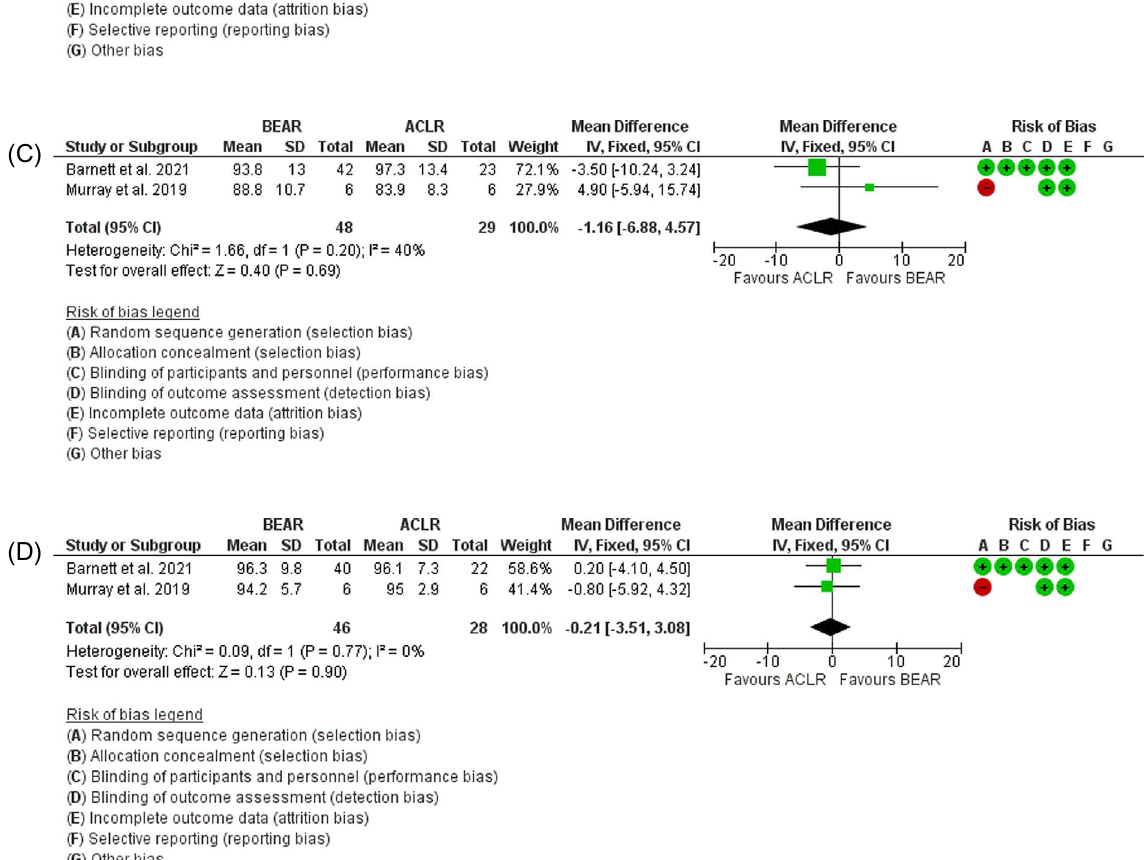
Figure 7. (A) Forest plot showing the 6m hop 2 years postoperatively in ACLR and BEAR. (B) Forest plot showing the triple hop 2 years postoperatively in ACLR and BEAR. (C) Forest plot showing the single hop 2 years postoperatively in ACLR and BEAR. (D) Forest plot showing the crossover hop 2 years postoperatively in ACLR and